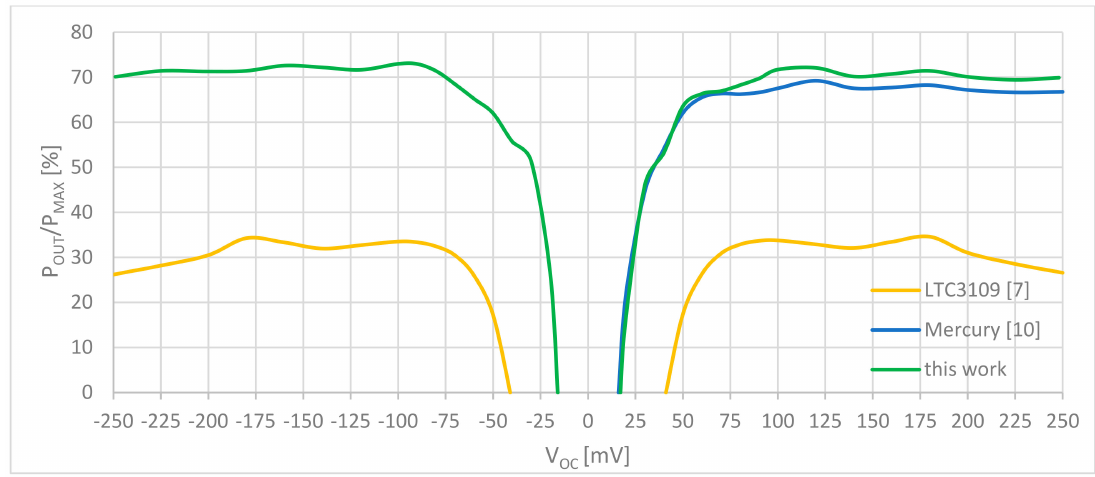
Figure 8. E ffi ciency vs. V OC for R TEG = 4 Ω and V OUT = 4.2 V.